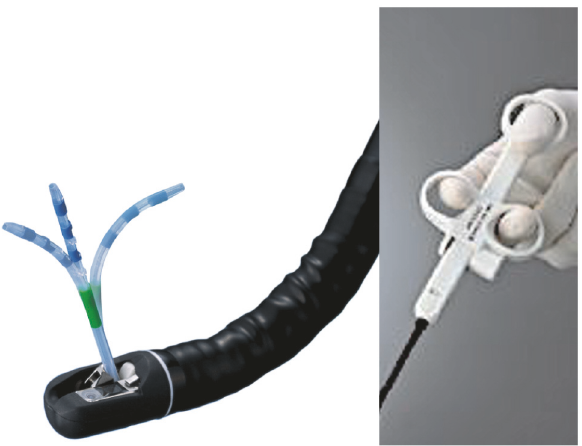
Figure 2: The Swing Tip has a flexible tip for manual